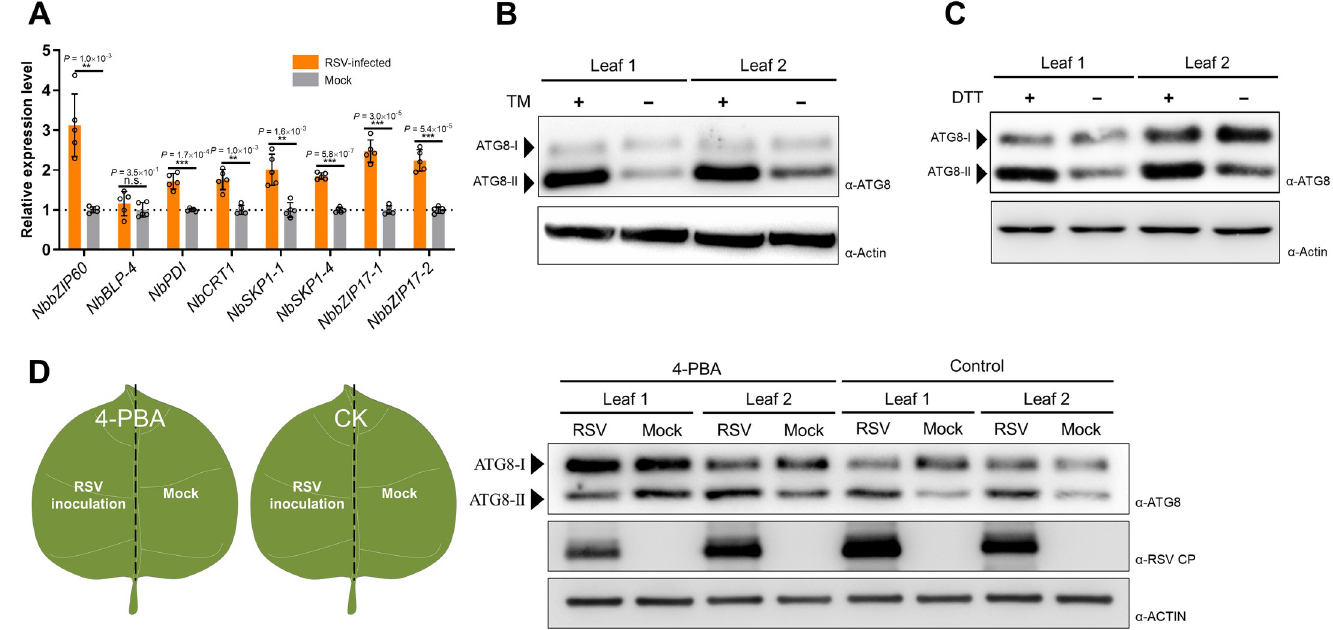
Fig 1. RSV infection induces host UPR and activates the autophagy pathway. (A) RT-qPCR analysis of the UPR-related genes in RSV-infected or healthy N . benthamiana at 12 dpi. NbActin was used as an internal reference in relative quantification. The values represent the means of relative expression levels ± SD relative to the mock plants ( n = 4 biological replicates). Data were analyzed by Student’s t -test, and asterisks denote significant differences between RSV-infected and mock plants (two-sided, �� P < 0.01, ��� P < 0.001, n.s., not significant). (B and C) Western blotting analysis of NbATG8 in N . benthamiana leaves treated with TM (B) or DTT (C). Each half of a leaf was treated with TM or DMSO for the TM test (B), DTT or ddH 2 O for the DTT test (C). The total protein was extracted at 18 hpt following by western blotting analysis. NbATG8 were detected by specific antibodies. Actin was used as loading controls. (D) Western blotting analysis of NbATG8 in RSV inoculated leaves pre-treated with 4-PBA. N . benthamiana leaves were pre-treated with 4-PBA at 12 h before inoculating RSV. The leaves were harvested at 6 dpi, and total protein was extracted for western blotting. Actin was used as loading controls. RSV CP indicated virus infection.